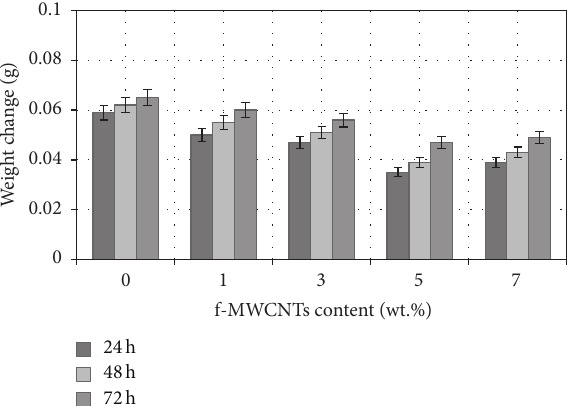
Figure 15: Effect of f-MWCNTs on corrosive properties of nano-